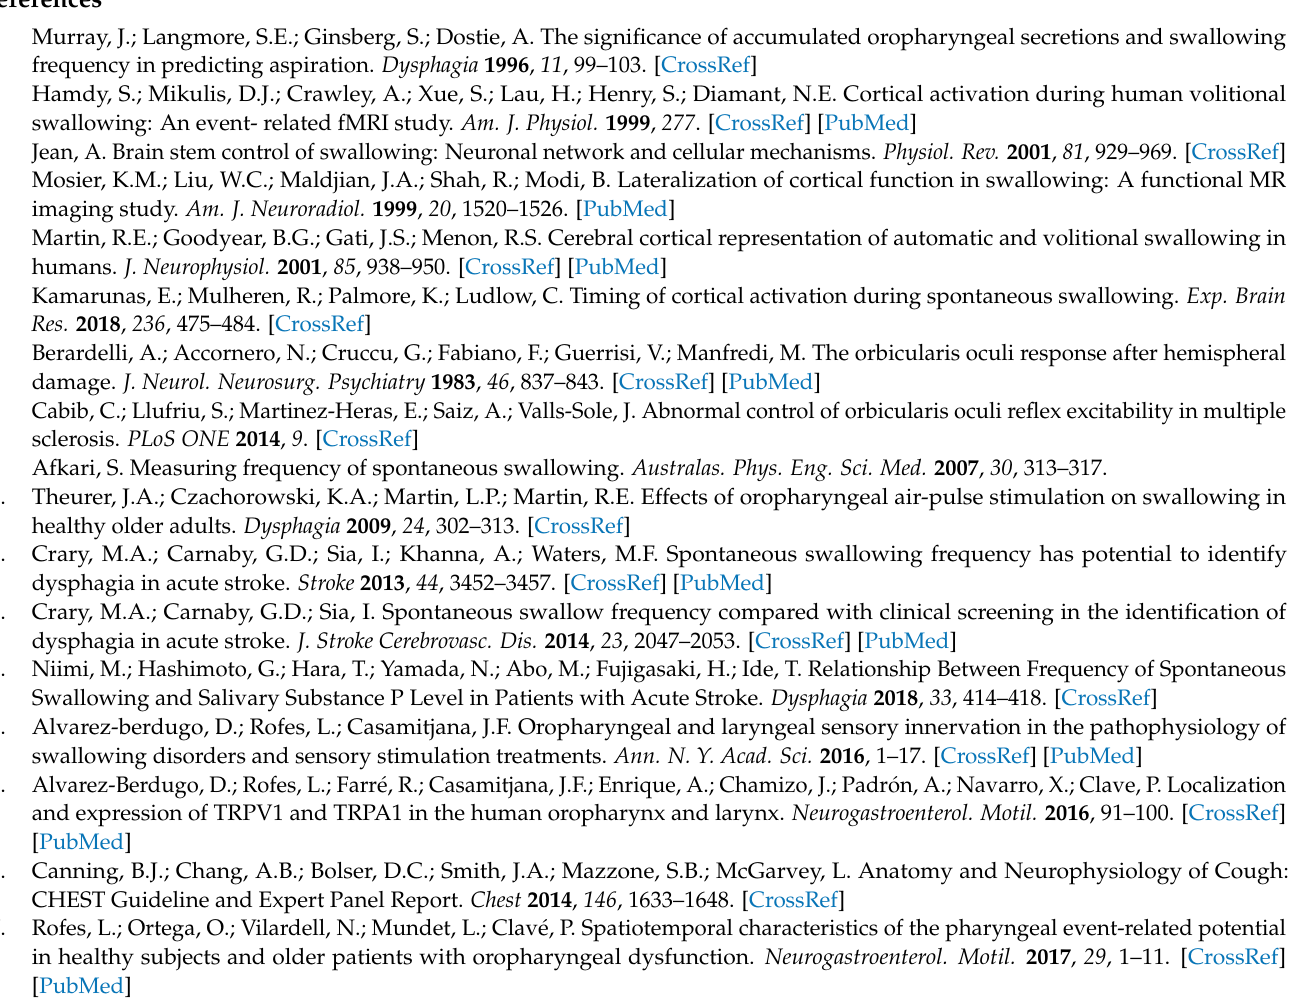
Figure S2. Example of a swallowing signal. The EMG signal is shown in red, the EMG integrated in green and the accelerometer in blue. EMG: